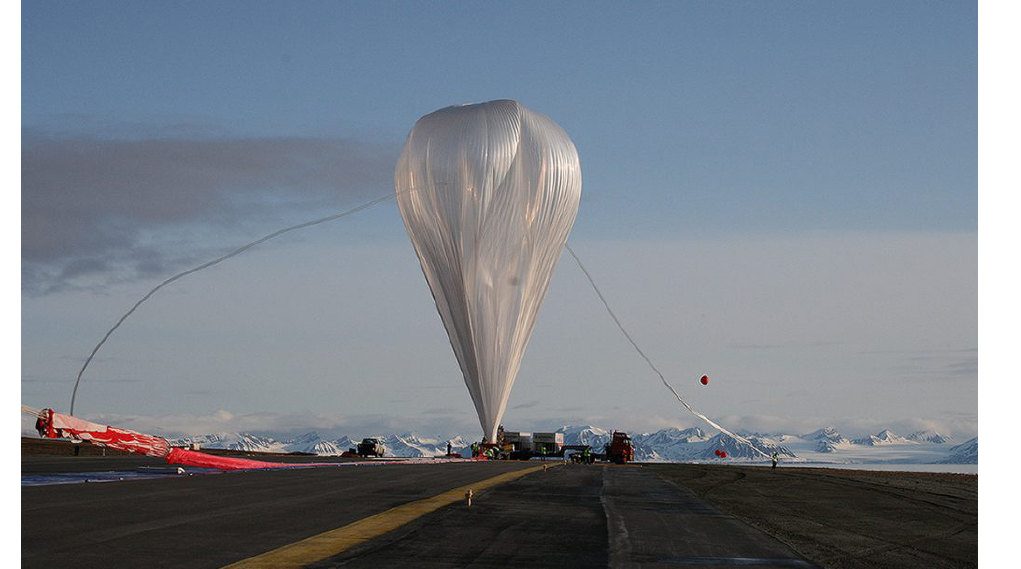
Figure 9. Balloon launch from the airfield at